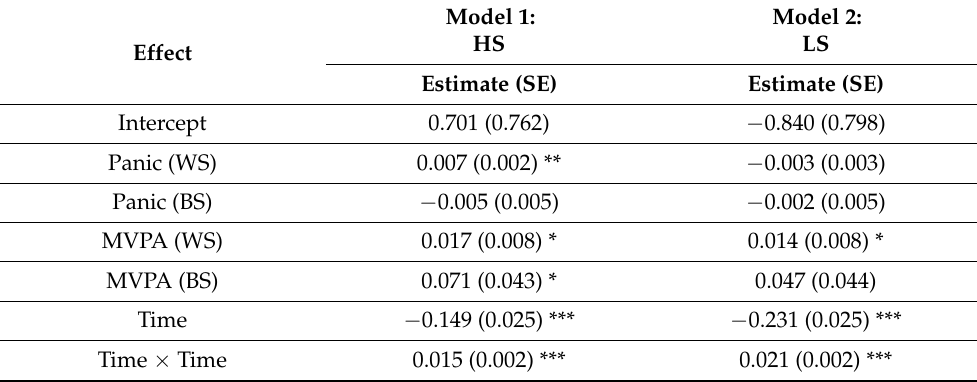
Table 3. Models of feeling panic, time spent in MVPA, and cortisol levels by meal